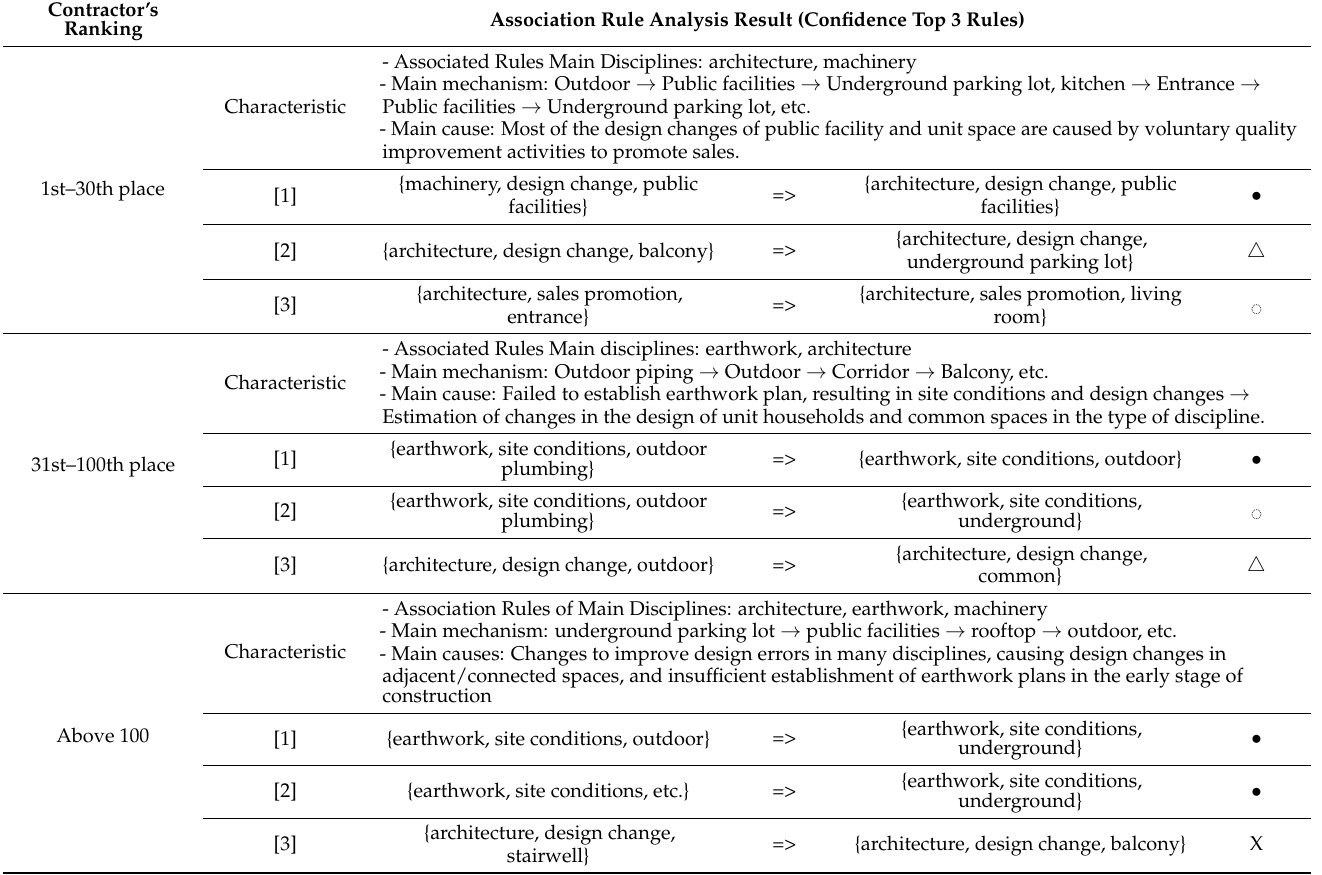
Table 6. Comparison of derivation result of design change association rule by project condition– contractor’s ranking.